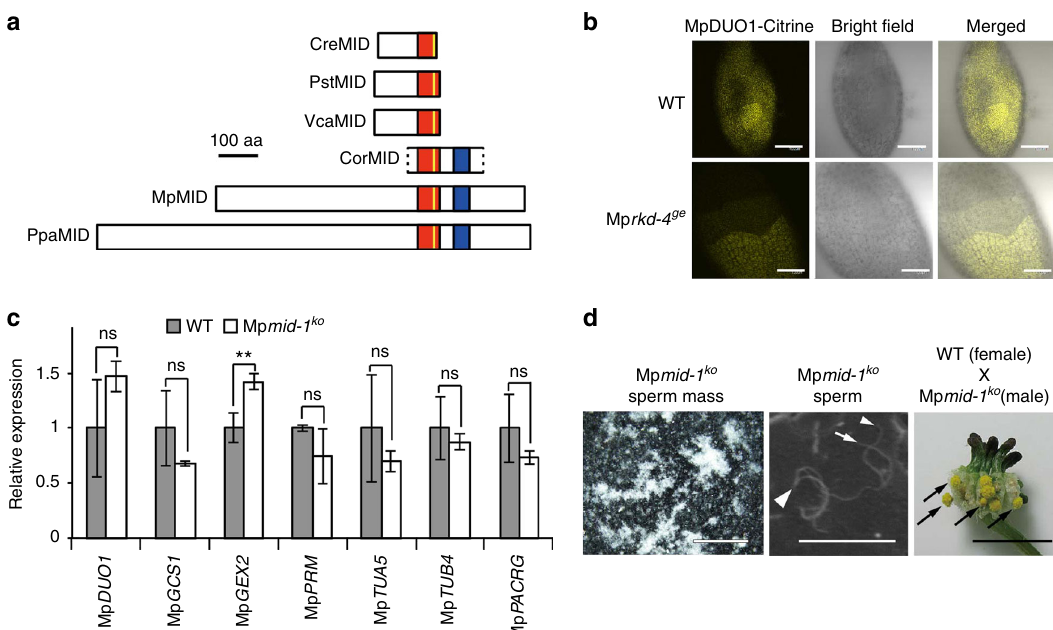
Fig. 6 Characterization of two RWP-RK transcription factor genes, Mp MID and Mp RKD , in Marchantia . a Schematic diagrams of Volvocine MID proteins and proteins of MID/RKD(C) subfamily 33 from Streptophytes. The red box represents the conserved RWP-RK domain while the yellow line indicates the RWP- RK motif. A blue box represents a conserved domain outside of the RWP-RK domain 33 , which corresponds to motif #12 of ref. 34 CreMID: Chlamydomonas reinhardtii (DQ355812), PstMID: Pleodorina starrii (BAF42661), VcaMID: Volvox carteri (ADI46915), CorMID: Coleochaete orbicularis (GBSL01000368 [partial sequence]), MpMID: Marchantia polymorpha (KU987912), PpaMID: Physcomitrella patens (XM_001779010). MID orthologs are not found in Arabidopsis thaliana and in Chara braunii . b The expression pattern of MpDUO1-Citrine fusion protein in developing antheridia of Mp DUO1-Citrine ki (WT) and Mp DUO1-Citrine ki ; Mp rkd-4 ge (Mp rkd-4 ge ) plants. Note that some sectors of spermatogenous cells differentiate to sperm while others fail in Mp rkd mutant antheridia 32 . c Quantitative real-time PCR analysis of Mp DUO1 , Mp GCS1 , Mp GEX2 , and genes involved in sperm morphogenesis in stage 4 antheridiophores of WT (gray bars) and Mp mid-1 ko (white bars). The relative expression of each gene in Mp mid-1 ko was compared with WT. Mp ACT1 was used as an internal control. Error bars indicate mean ± SD; n = 3. (** p < 0.01; ns, not signi fi cant; Student ’ s t -test). d The sperm masses (white) discharged from mature antheridiophores of Mp mid-1 ko into water (left) and the scanning electron micrograph of sperm of Mp mid-1 ko (middle). White arrowhead and arrows indicate the nucleus and fl agella, respectively. The right panel shows mature sporangia (black arrows) on a WT archegoniophore a month